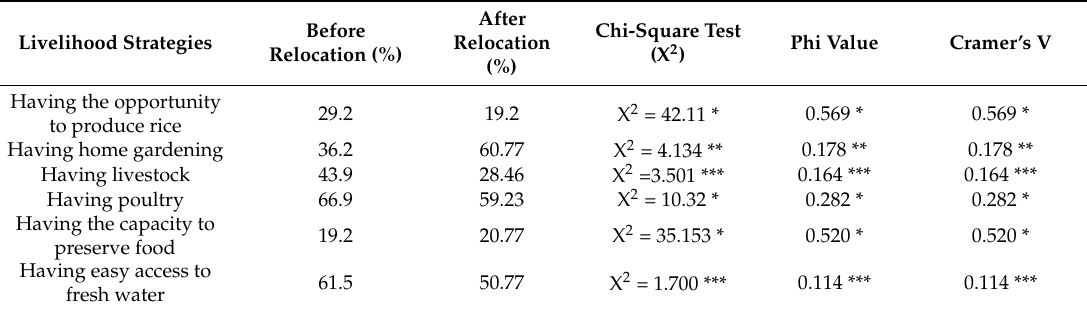
Table 4. Strategies related to food security, before and after